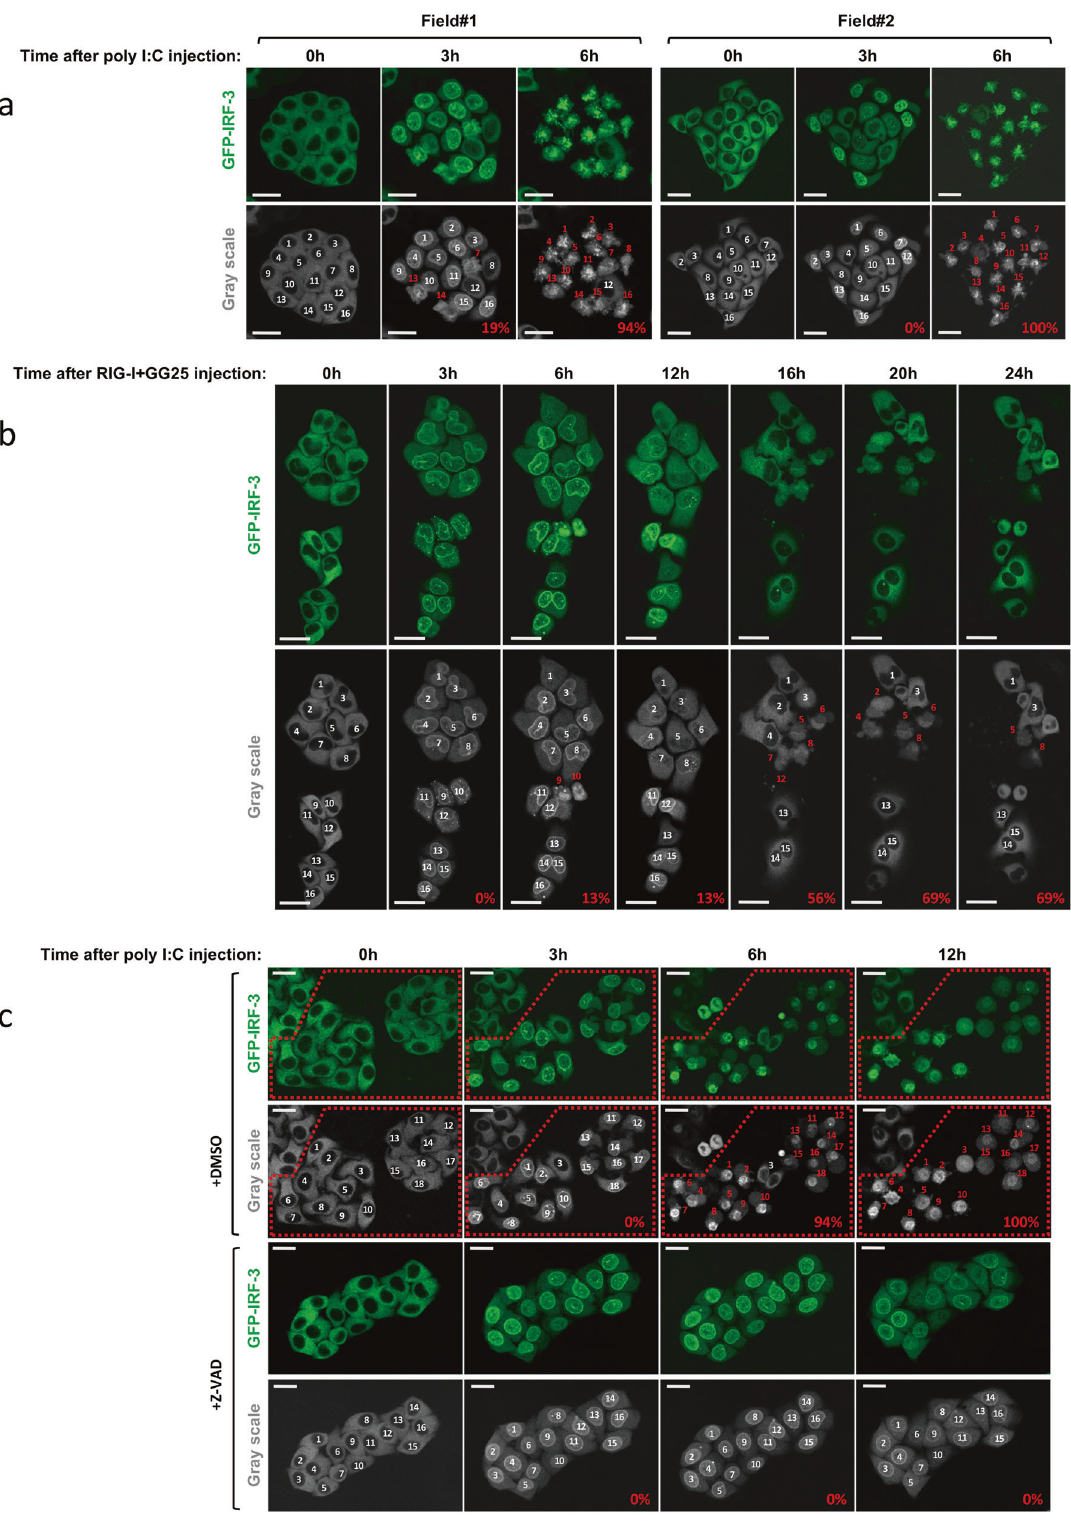
Fig. 2 Induction of the nuclear translocation of IRF-3 and subsequent cell death by the cytoplasmic injection of RNA/protein. a GFP-IRF-3 HeLa cells were injected with poly I:C (1 μ g/ μ l) and observed live for the localization of IRF-3 at the indicated times after the injection. Injected cells were numbered (white) and followed; cells with red numbers exhibited morphological cell death; % of dead cells was calculated (as depicted in grayscale images). b GFP-IRF-3 HeLa cells were injected with RIG-I and GG25 (1 μ g/ μ l each) and observed as in ( a ). c GFP-IRF-3 HeLa cells were injected with poly I:C (1 μ g/ μ l) in the absence (DMSO) or presence of Z-VAD (20 µ Μ ) and observed as in ( a ). Z-VAD was added 3 h prior to the injection and kept in the culture medium. Injected cells are indicated in the red dotted box. Scale bar = 25 µm.